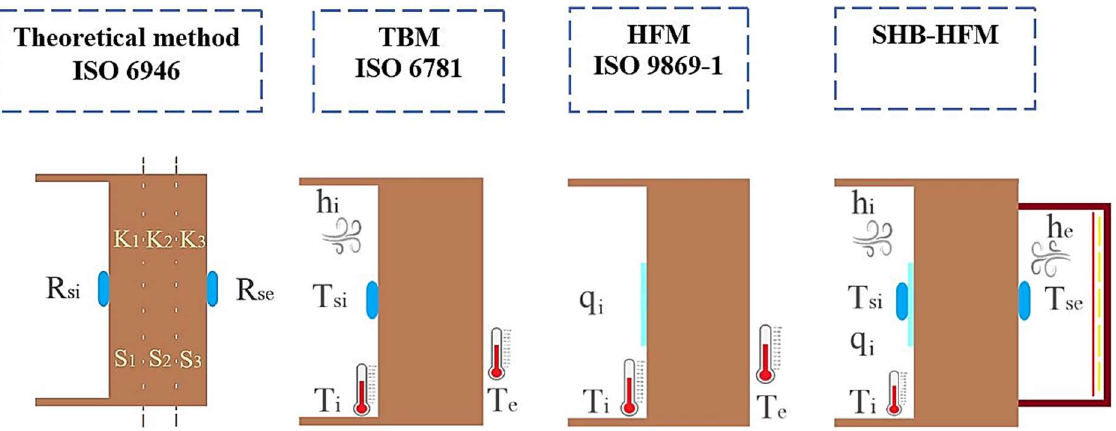
Figure 1. Schematic of the current techniques for thermal parameter diagnosis of the building envelops [24].